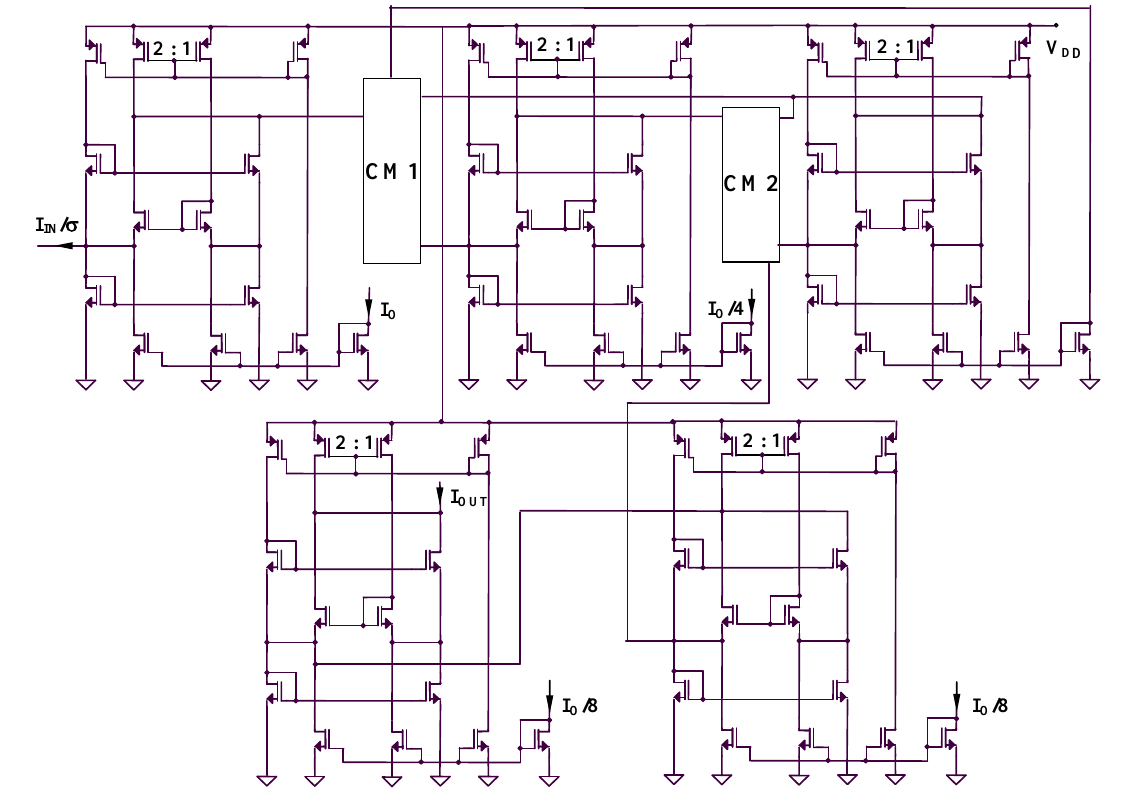
Figure 3. The CMOS implementation of the original Gaussian function generator.